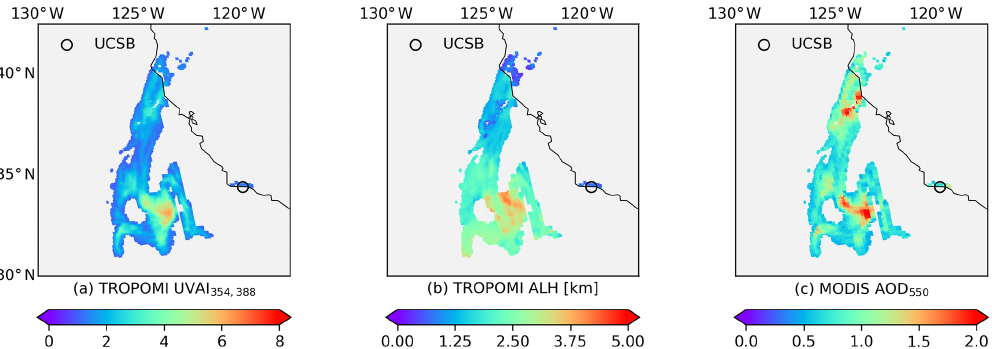
Figure 2. Satellite data from the Californian fire event on 12 December 2017: (a) TROPOMI UVAI calculated by reflectance at 354 and 388nm; (b) TROPOMI ALH (unit: km); (c) MODIS AOD at 550nm.